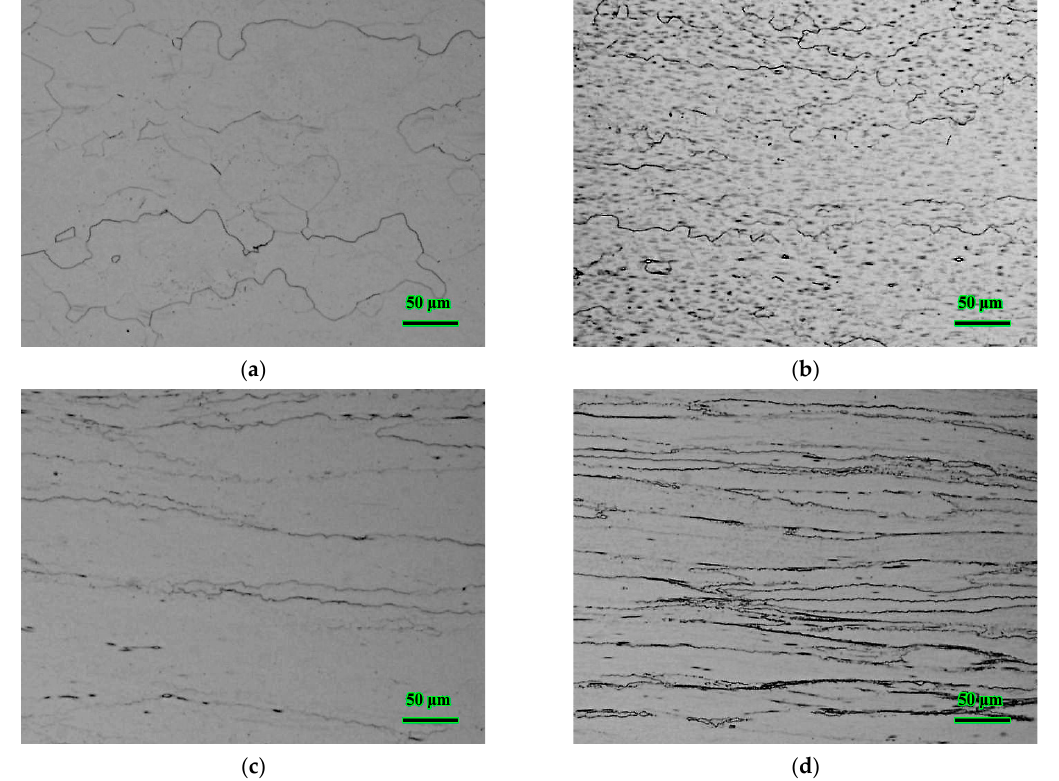
Figure 12. The microstructure of different strain rate at 840 °C: ( a ) 0.001 s − 1 ; ( b ) 0.01 s − 1 ; ( c ) 0.1 s − 1 ; ( d ) 1 s − 1 .